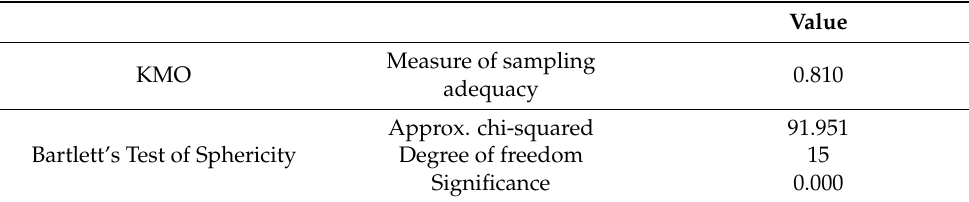
Table 3. Kaiser–Meyer–Olkin and Bartlett’s